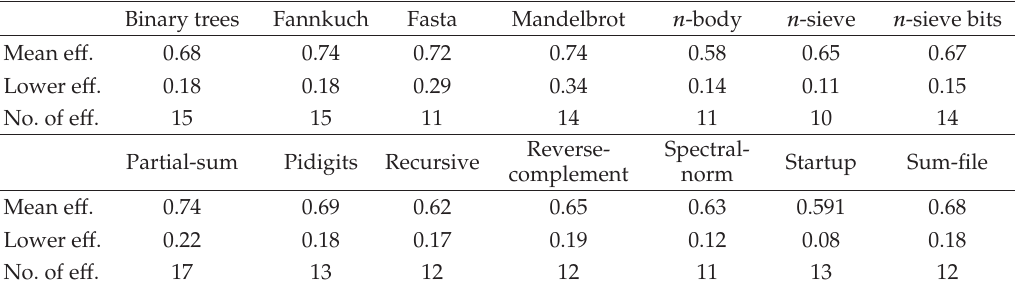
Table 2: Summary of the results of the DEA analysis: mean and lowest e ffi ciency scores over the available set of benchmark